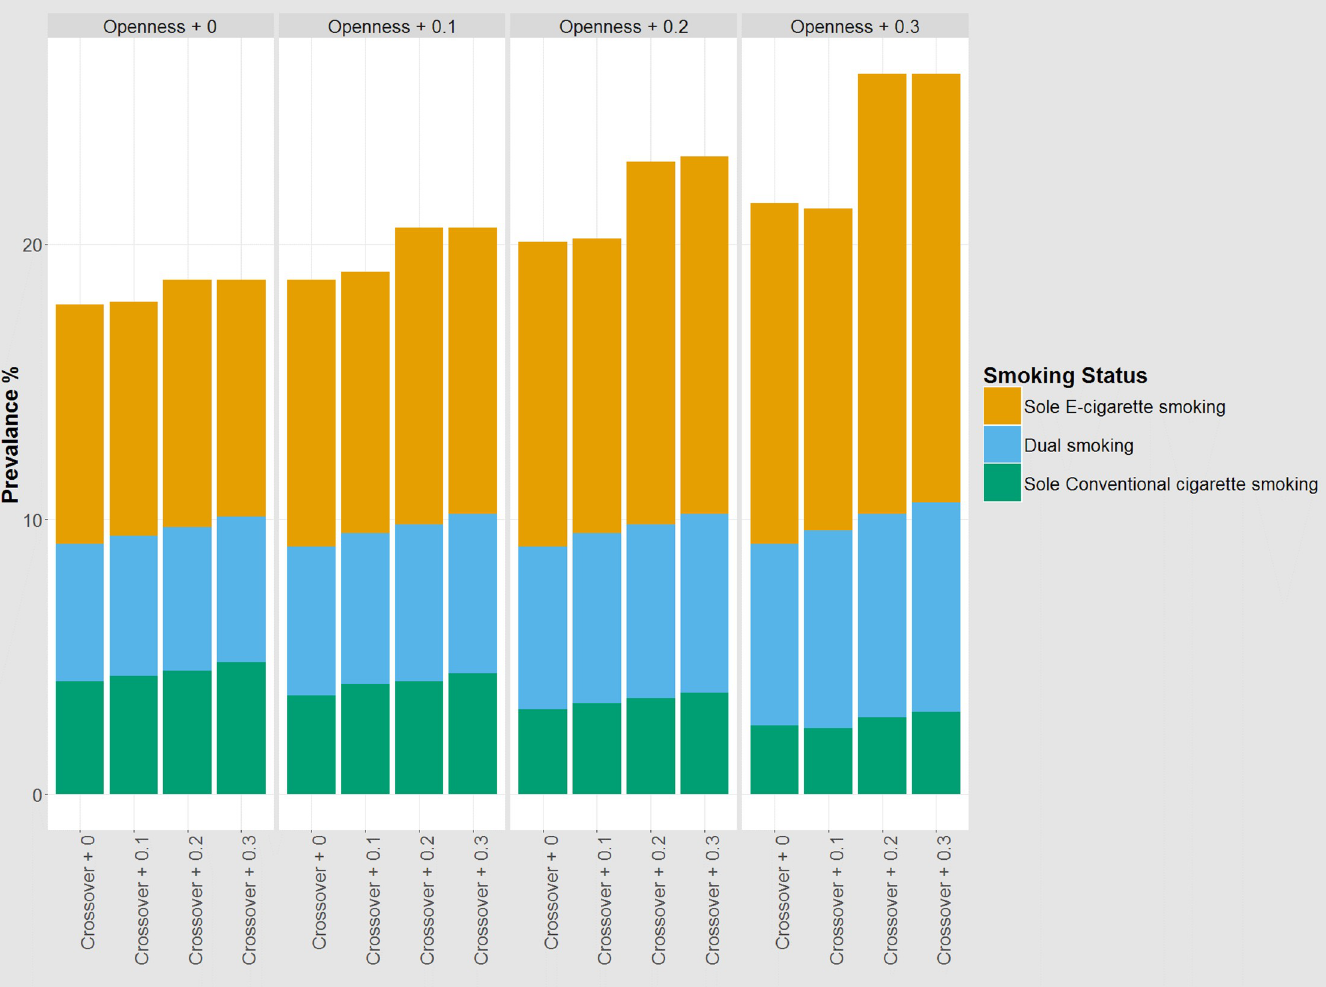
PLOS ONE | https://doi.org/10.1371/journal.pone.0221557 August 29,